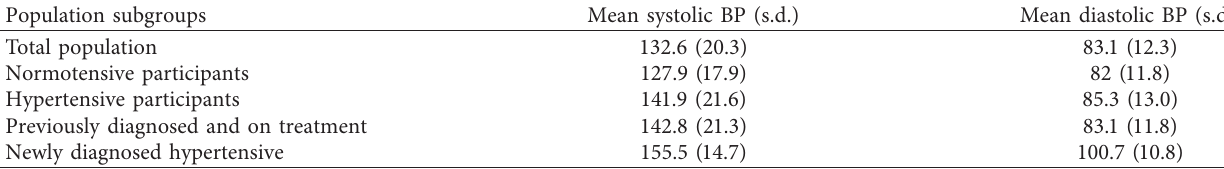
Table 1: Mean blood pressure in different groups in the SWADES cohort (in mmHg).